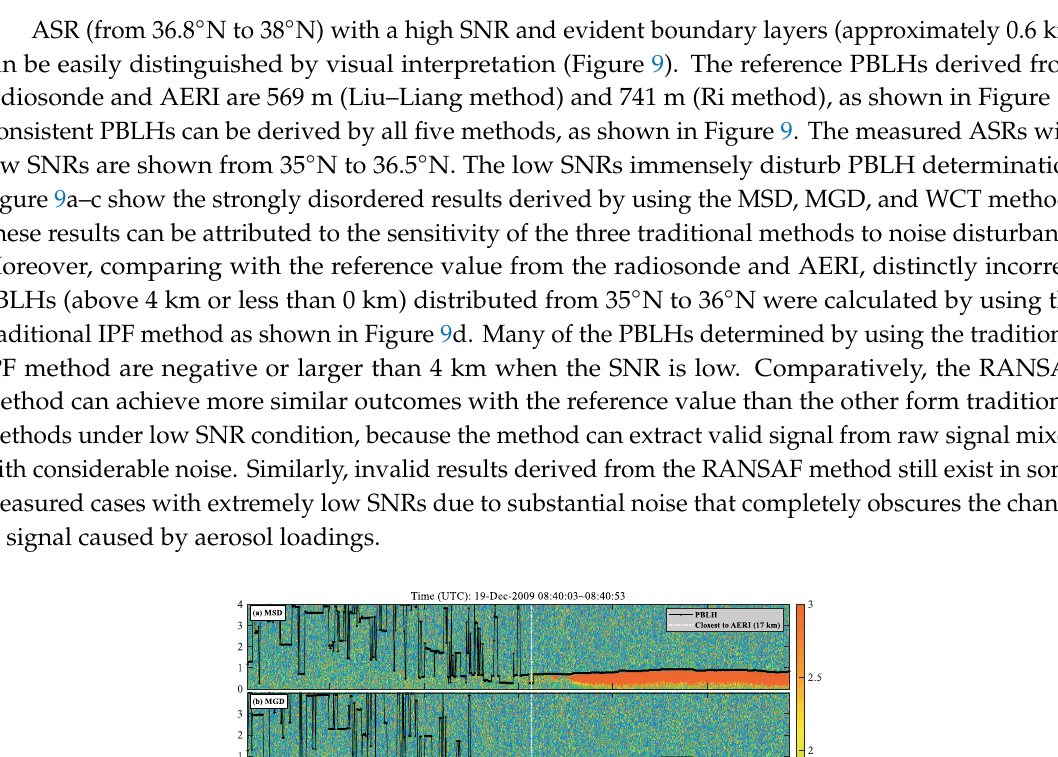
Figure 8. PBLHs were determined with the ( a ) radiosonde (RS) at 17:28 and ( b ) AERI at 19:43 on 21 October 2009 (UTC); ( c ) ARM SGP site of radiosonde observations and CALIPSO trajectory. The minimum distance between the CALIOP and radiosonde (AERI) measurements are shown in the top of subfigure ( c ).